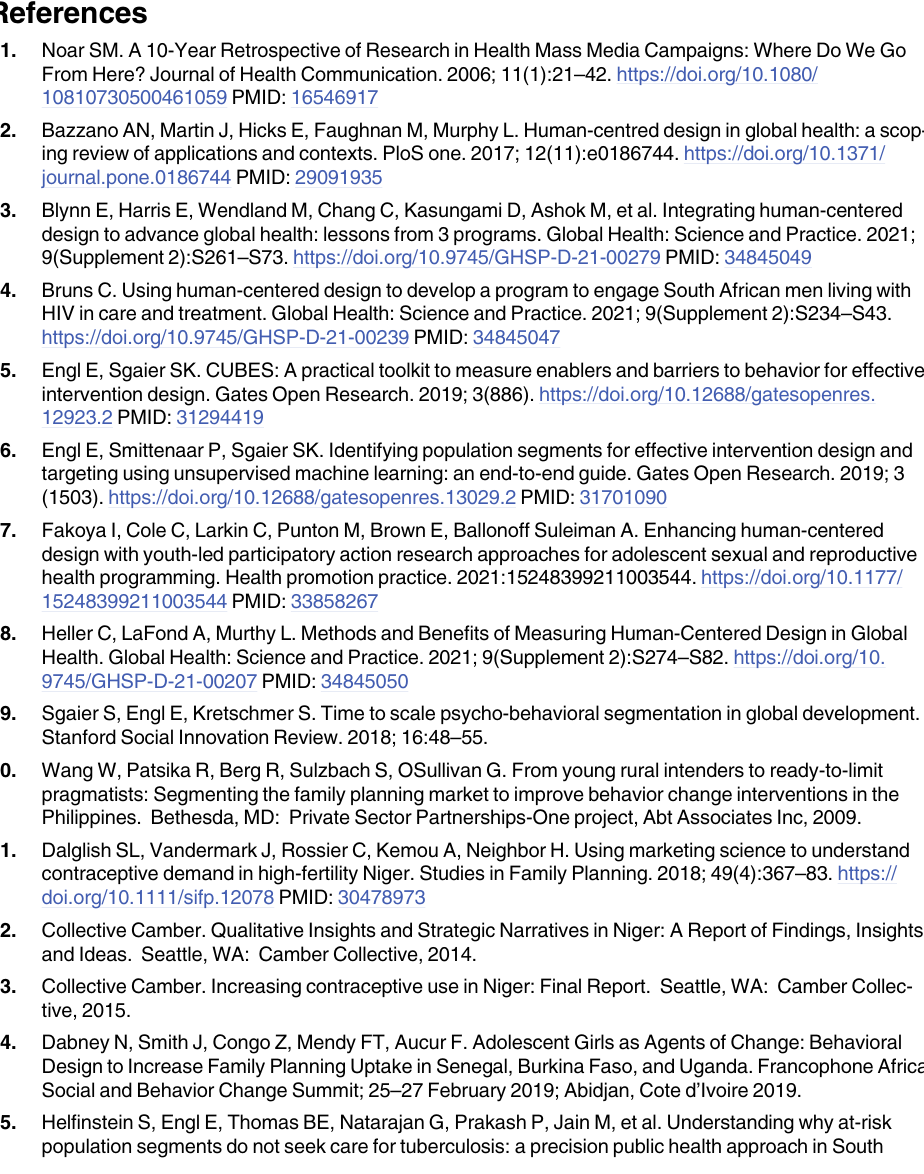
S1 Table. Analytic sample profile, by contraceptive